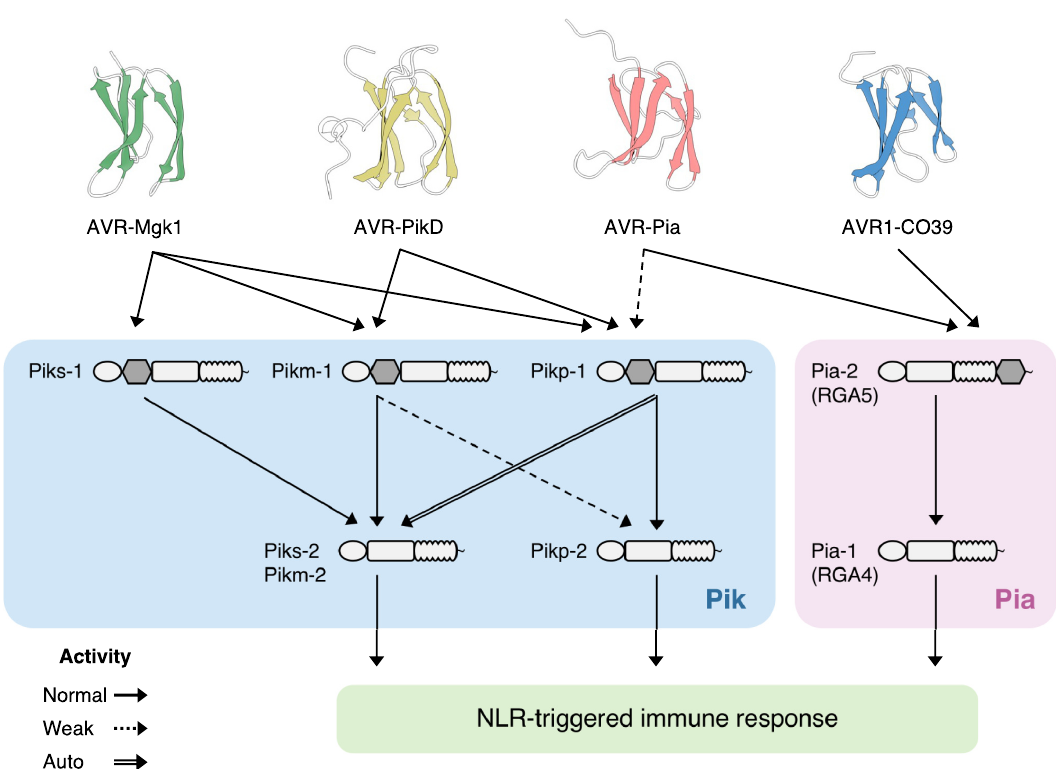
Fig 10. Beyond the gene-for-gene model: complex interactions between MAX effectors and rice NLR pairs. The NLR pairs Pik (Pik-1/Pik-2) and Pia (Pia-2/Pia-1, also known as RGA5/RGA4) have an integrated HMA domain (gray) in their sensor NLRs (Pik-1 and Pia-2). The Pia-2 HMA domain binds the sequence-unrelated MAX effectors AVR-Pia and AVR1-CO39 [69]. The Pikp-1 HMA domain weakly binds AVR-Pia, while that of Pikm-1 cannot [116]. The AVR-Mgk1 effector is detected by several Pik proteins, including Piks, which does not respond to AVR-PikD. Complex interactions also occur between sensor and helper NLRs forming homo- and hetero-complexes [98,118].An allelic mismatch of a receptor pair leads to autoimmunity (Pikp-1/Pikm-2) or reduced response (Pikm-1/Pikp-2) due to allelic specialization [119].The structures of AVR-Mgk1 predicted by AlphaFold2 [108], AVR-PikD (PDB ID: 6FU9 chain B) [71], AVR-Pia (PDB ID: 6Q76 chain B) [116], and AVR1-CO39 (PDB ID: 5ZNG chain C) [75] were visualized by ChimeraX [120]. AVR, avirulence; HMA, heavy metal-associated; NLR, nucleotide-binding domain and leucine-rich repeat protein